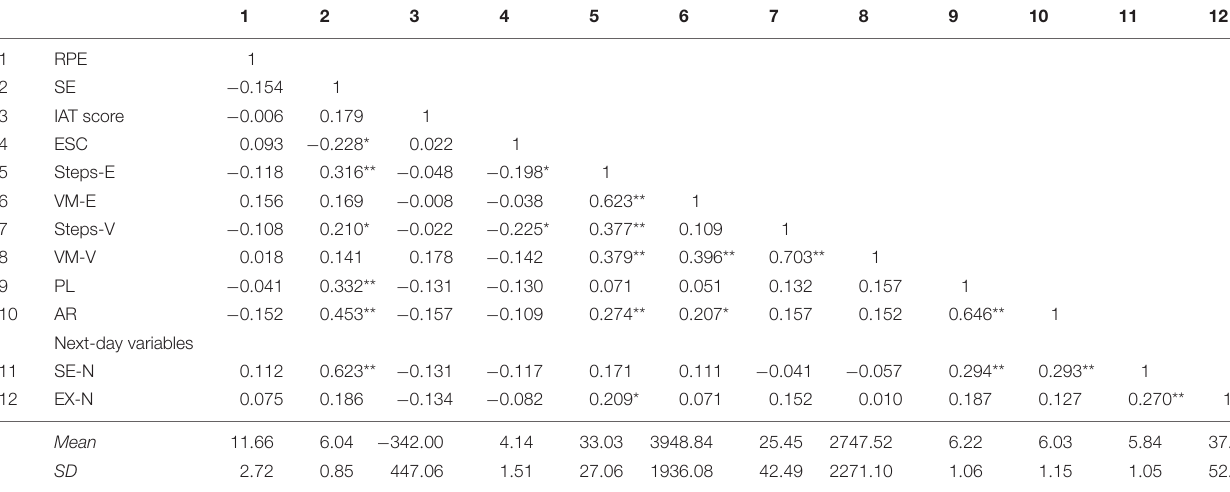
participants ( M = 6.41, SD = 0.60, N = 27), p = 0.01. Among the female participants, the young avatar group ( M = 6.41, SD = 0.60, N = 27) also reported greater self-efficacy for exercise than the older avatar group ( M = 5.96, SD = 0.96, N = 26), p = 0.05. The main effects of avatar age, F = 0.293 (1, 104), p = 0.59, partial η 2 = 0.003, and sex, F = 3.19 (1, 109), p = 0.007, partial η 2 = 0.03, were not significant. H1a was not supported. However, regarding RQ3b, the interaction effect on exercise self-efficacy was